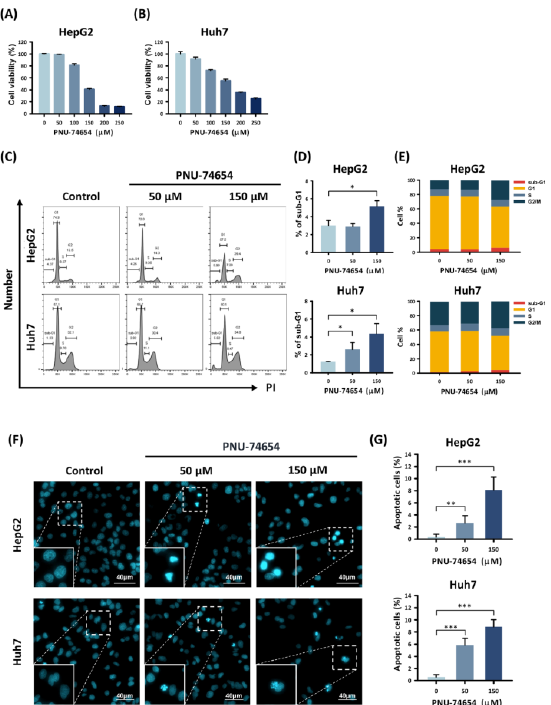
Figure 1. The effects of PNU-74654 on the survival of HCC cells. ( A , B ) Effects on cell viability, determined by viability assays in HepG2 and Huh7 cells. ( C ) Cell cycle distribution after 72 h treatment with PNU-74654 ( D , E ) Proportion of HCC cells in the sub-G1 cell cycle stage. ( F ) Apoptotic cells labeled by Hoechst staining. ( G ) PNU-74654 dose response of the percentages of apoptotic HCC cells. The data are presented as mean ± SD (* p < 0.01 ; ** p < 0.01; *** p < 0.001).